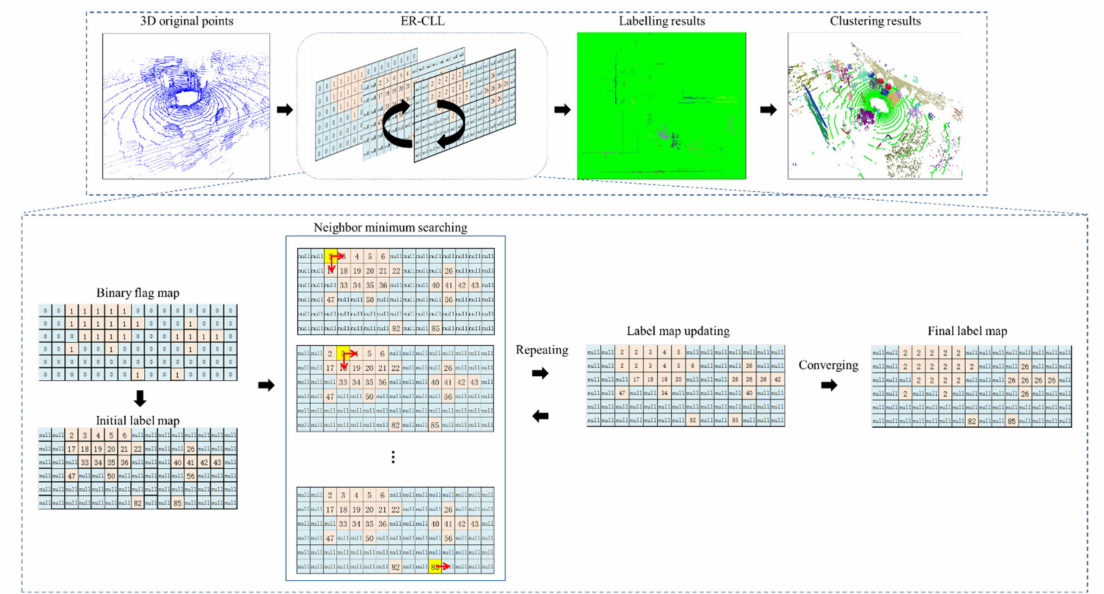
Figure 1. Flowchart of proposed fast spatial clustering